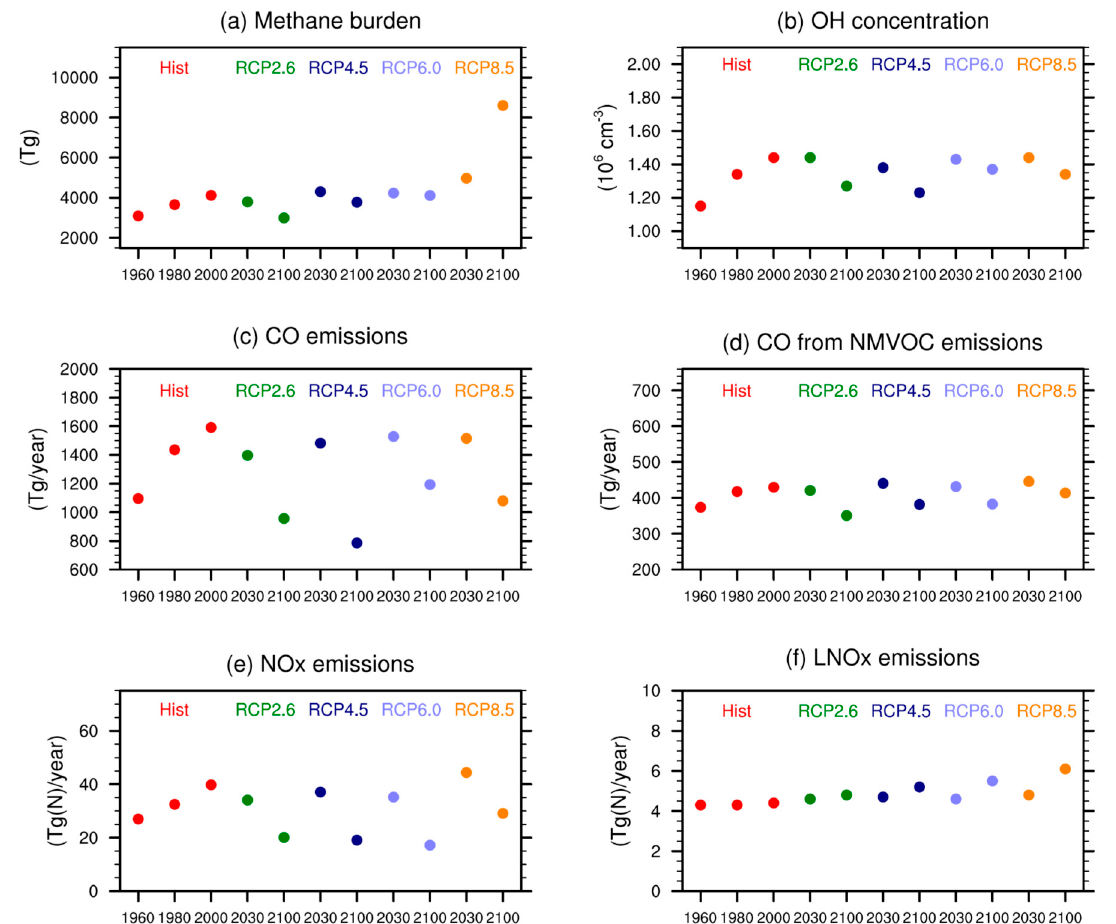
Figure 1. Emissions used for the SOCOLv3 (Solar Climate Ozone Links version 3) simulations carried out for this study, as well as SOCOLv3 tropospheric burdens of important species. ( a ) tropospheric methane burden; ( b ) tropospheric mean OH concentrations; ( c ) annual total CO emissions; ( d ) CO from NMVOC (Non Methane Volatile Organic Compound) oxidation; ( e ) total NO x emissions; and ( f ) lightning NO x emissions calculated online based on the cloud top height.